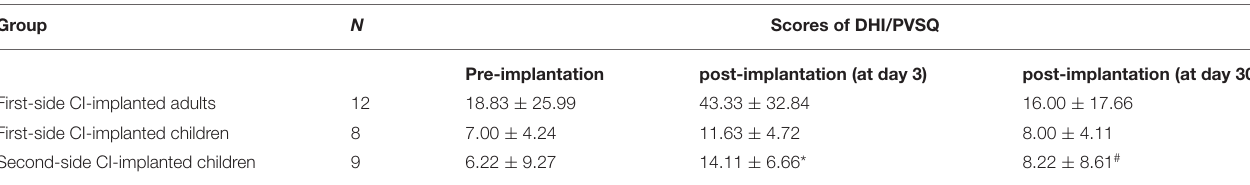
TABLE 2 | The pre- and post-implantation (at day 3 and at day 30) scores of Dizziness Handicap Inventory (DHI) for adults and Pediatric Vestibular Symptom Questionnaire (PVSQ) for children. Group N Scores of DHI/PVSQ